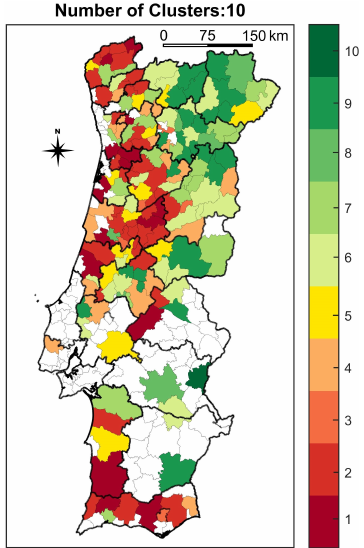
Figure 7. Spatial distribution of clusters. Cluster colours are the same as in Fig. 6. Municipalities without colour were excluded from the cluster analysis, justifying only 5.2% of